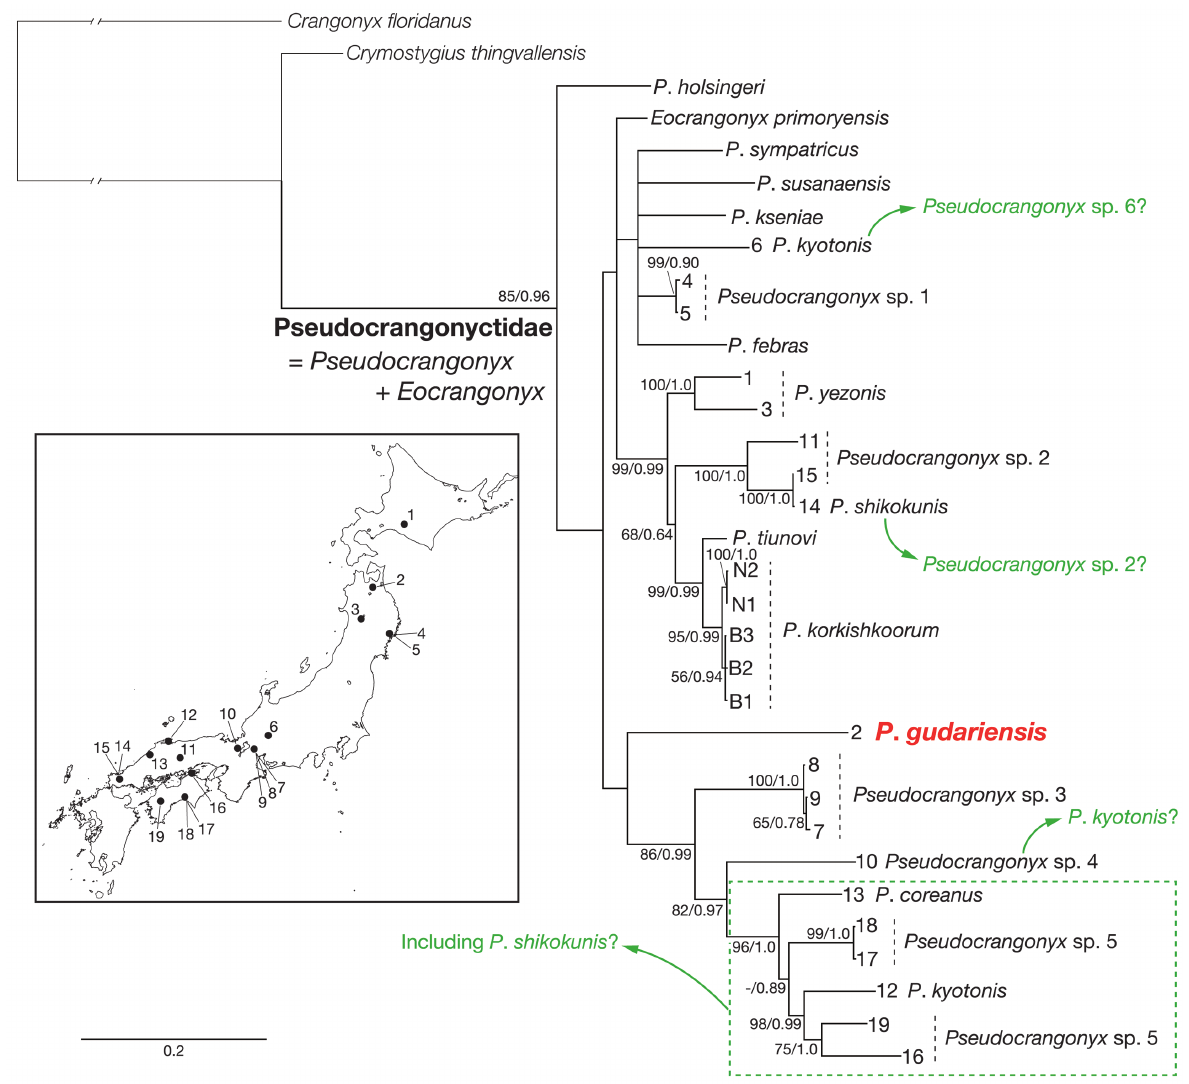
Figure 10. Bayesian inference tree for 2,397 bp of nuclear 28S rRNA plus histone H3 and mitochondrial COI and 16S rRNA markers, with the map modified from Fig. 1. Numbers on nodes represent bootstrap values for maximum likelihood and Bayesian posterior probabilities. Specimen numbers are also shown in Fig. 1 and Table